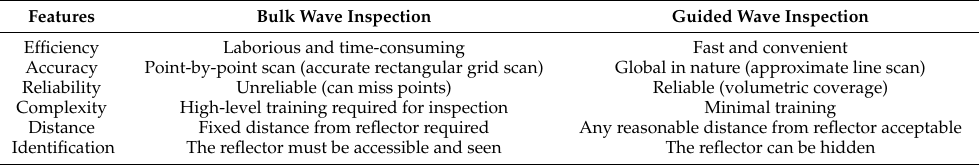
Table 1. Comparison between bulk wave inspection and guided wave inspection